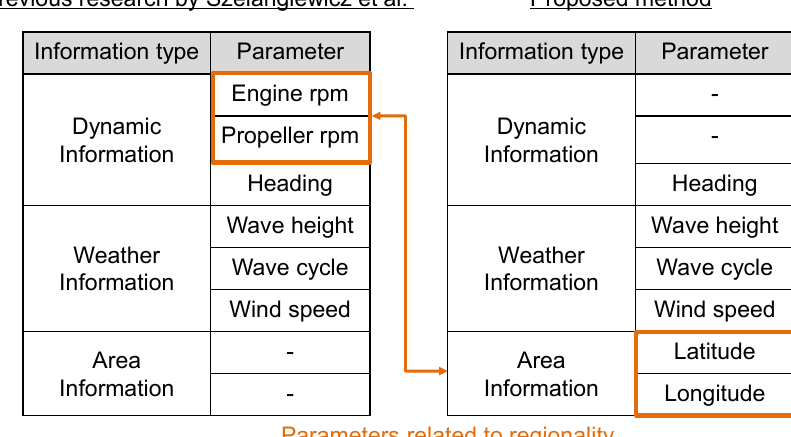
Figure 3. Comparison between this study and a previous study.